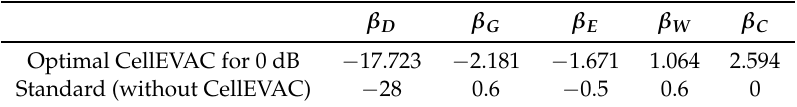
Table 1. Optimal parameter configuration for the CellEVAC MLM decision logic model, and parameter configuration of the MLM pedestrians’ standard behavior